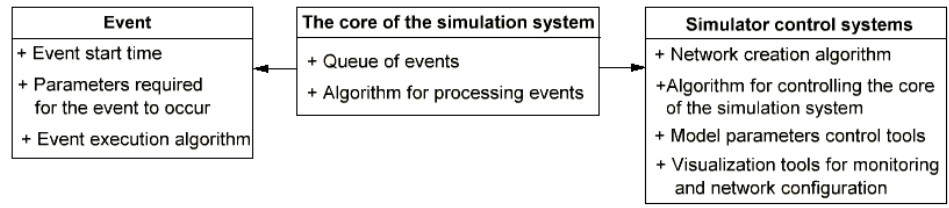
Figure 5. Unified Modeling Language (UML) diagram of the developed simulator.